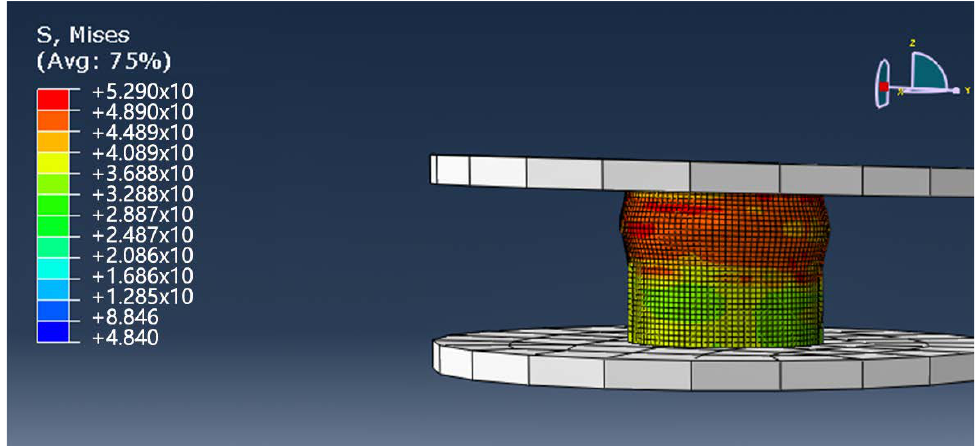
Figure 11. The compression simulation of the 3D tubular woven composites at 0.28 s.